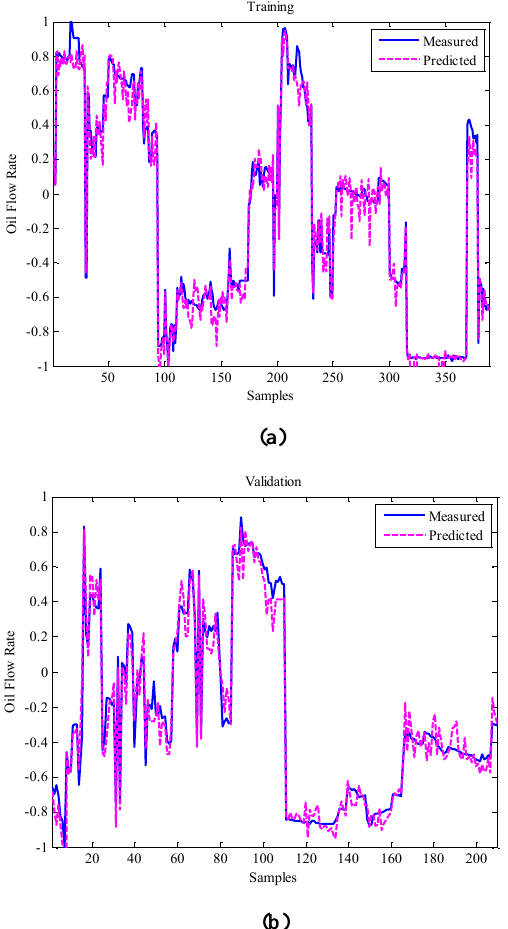
Fig. 8. Comparison between measured and predicted oil flow rate for ANFIS model, (a) training, (b)